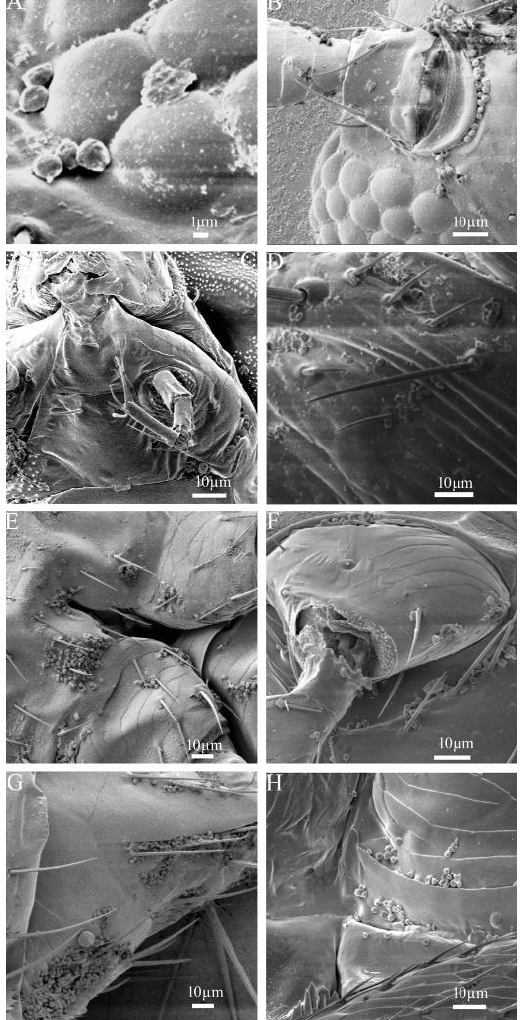
Figure 2. Representative scanning electron micrographs (SEMs) of the fungal infection process. B. bassiana fungal conidia visualized: ( A ) between the ommatidia of the compound eye, ( B ) on the antenna, ( C ) around the mouthparts, ( D ) on the basal area of the insect head, ( E ) attached to the thorax, ( F ) around the base of the legs, ( G ) at the end of the host abdomen, and ( H ) on the intersegmental folds in the abdomen.